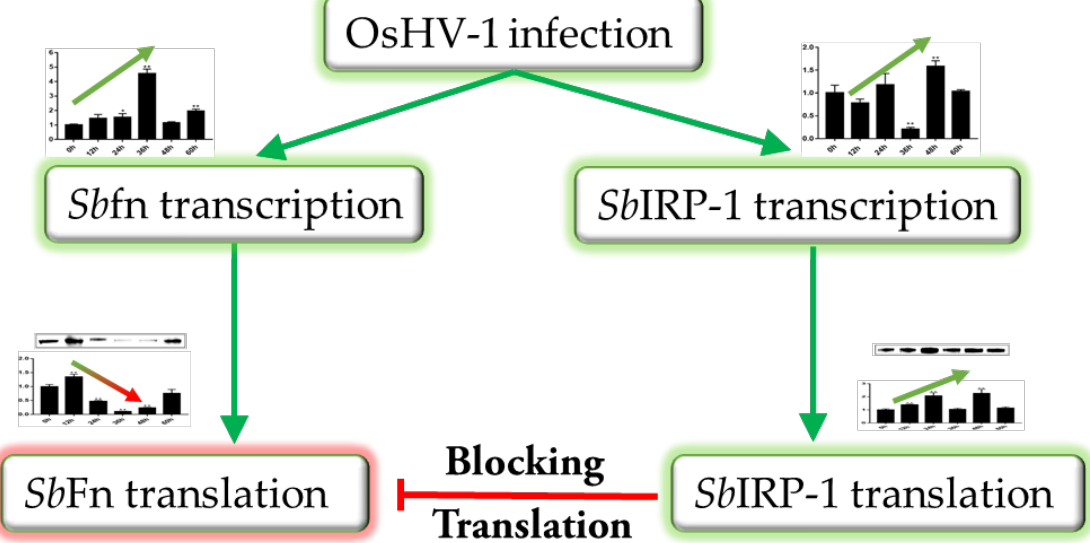
Figure 8. Illustration of the regulatory role of Sb IRP-1 on Sb Fn post-OsHV-1 infection. Iron homeostasis in mammalian cells is orchestrated post-transcriptionally by the IRE/IRP system [42]. IRE/IRP1 interaction directly responds to changes in cellular iron content; IRE-binding activity of IRPs is high in iron-deficient conditions and low in iron- sufficient conditions [43]. Here, an IRP1 protein in ark clams ( Sb IRP-1) was found with an open and a closed conformation, while IRP2 was missing in the genome of ark clams [35]. Moreover, Sb IRP-1 possesses three putative RNA binding domains and aconitase active sites, implying the versatile role of Sb IRP-1 as RNA binding molecule and aconitase. The IRE was conservatively identified in the 5 ’ -UTR of Sb Fn mRNA, resembling ferritin genes across invertebrates, including mollusks, such as housefly ( Musca domestica ), prawn ( Mac- robrachium nipponense ), scallop ( Chlamys nobilis ), clam ( Ruditapes decussatus ), abalone ( Hali- otis rufescens ), and mussel ( Perna viridis ) [44 – 49]. The location of the Sb Fn IRE satisfied the requirement for effective translation inhibition, with a total of 20 – 30 nucleotides located 90 bp downstream of the transcription start site [50,51]. The IRE/IRP system served conservatively to regulate iron homeostasis in ark clams and a high affinity between r Sb IRP-1 and the IRE of Sb Fn was revealed by EMSA. When Sb IRP-1 was knocked down in vivo by RNAi, the translation of Sb Fn was increased and the accumulation level of Sb Fn could be detected in hemocytes by western blot, even without significant changes in Sb Fn mRNA